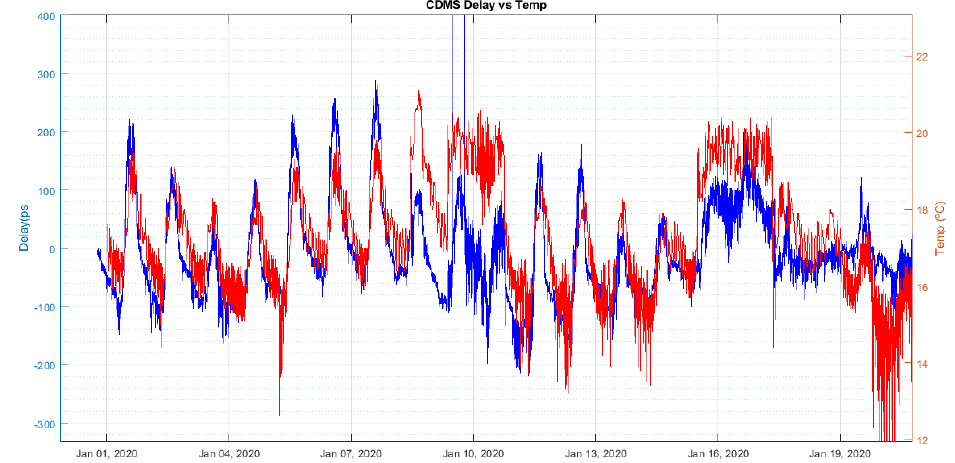
Figure 18. Comparison between receiver room temperature (red) and cable delay